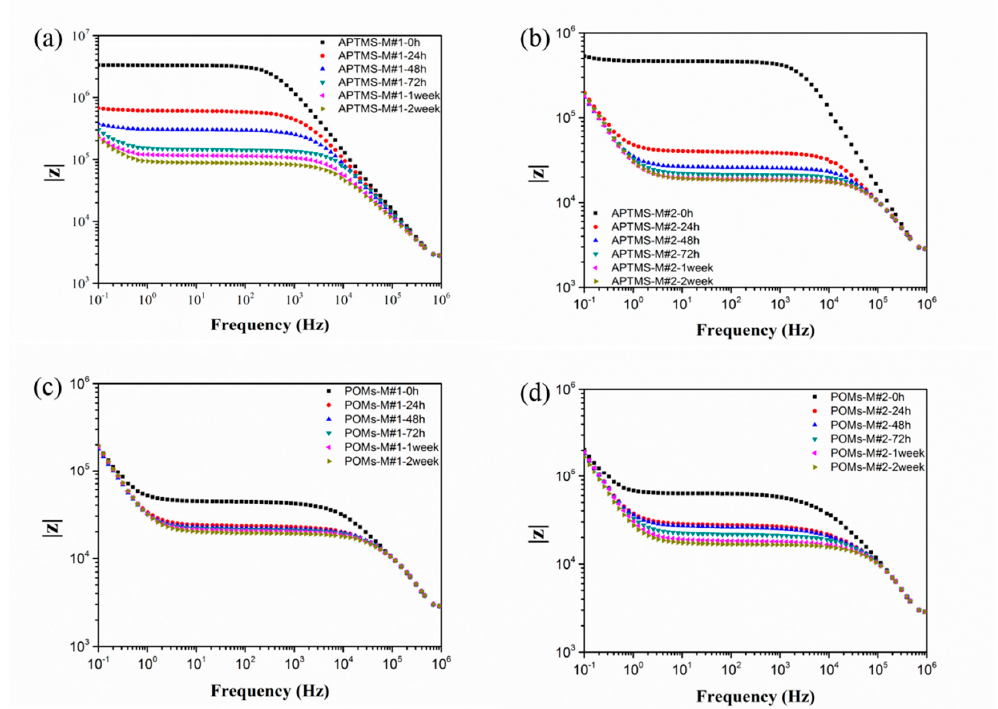
Figure 10. Bode plots of EIS analysis in terms of immersion time in 0.01 mol/L KCl solution: ( a ) APTMS-M#1, ( b ) APTMS-M#2, ( c ) POMs-M#1, and ( d ) POMs-M#2.